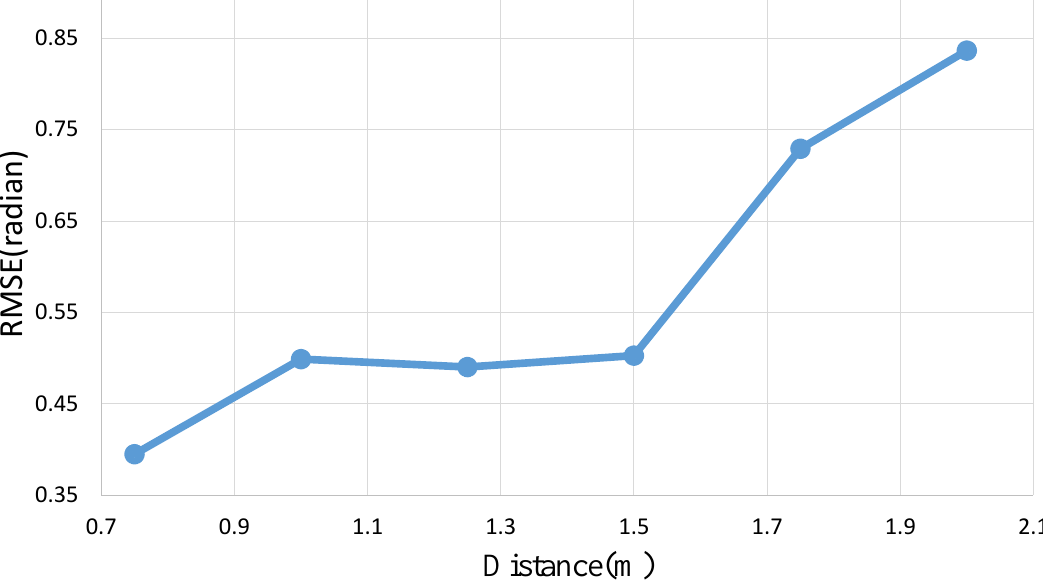
Figure 9. Variation of the accuracy of the normal map with distance from the image sensor. We captured a planar object moving horizontal direction at each distance. The speed of the planar board was 1.3 m/s. We estimated the surface normals using Equation (6) under point light source assumption and calculated the root mean square error (RMSE) in radians between the estimated surface normal and the orthogonal normal vector of the plane using Equation (9). The accuracy decreases as the distance between the image sensor and the target scene increases because of lighting